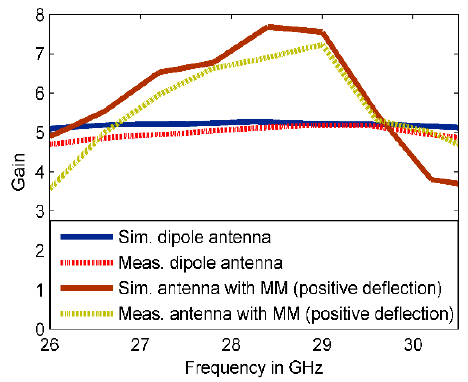
Figure 13. Simulated and measured gain of the antenna and MM antenna for positive deflection at 28 GHz.